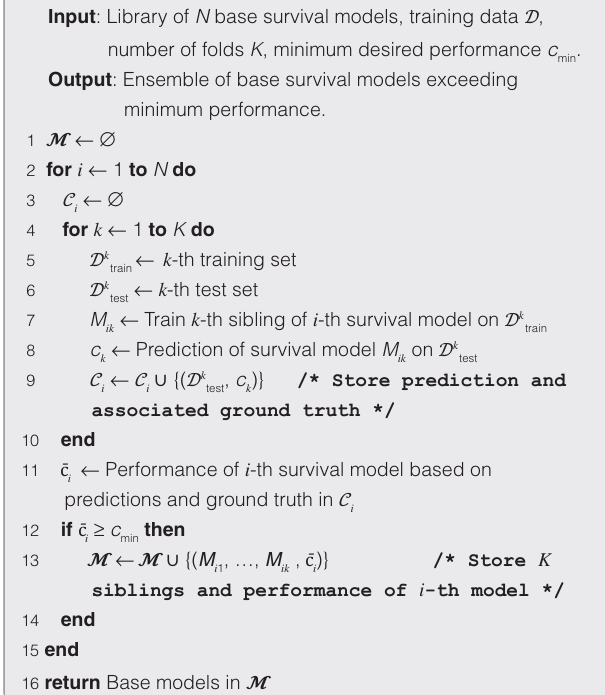
Algorithm 1. Ensemble selection for survival